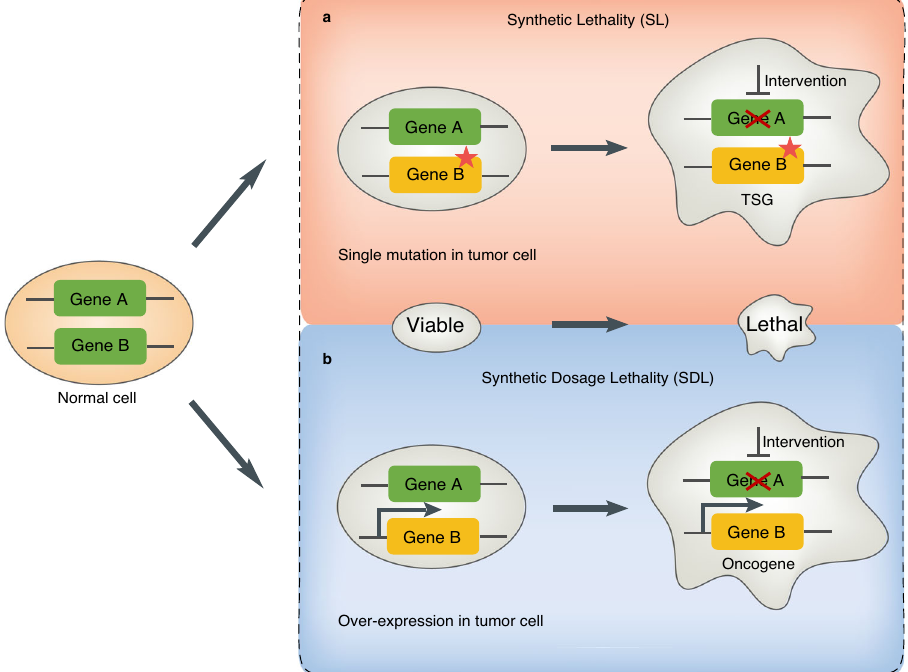
Fig. 1 The principle of SL and SDL. For gene A and B, if only one gene has a mutation or an overexpression in the tumor cell, the tumor cell is still alive. However, the pharmacological intervention of the partner gene will result in SL interaction in tumor cell which has a loss-of-function mutation of the tumor suppressor gene (TSG) ( a ). In addition, the pharmacological intervention of the partner gene will result in SDL interaction in tumor cell which has a gain-of- function mutation or an overexpression of the oncogene ( b ). The red star denotes a mutation. The thicker arrow denotes an overexpression. The cross line denotes a pharmacological